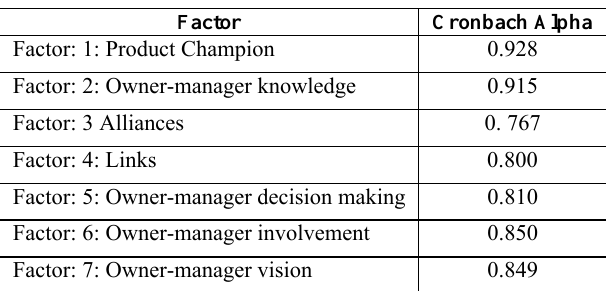
Table 2: Cronbach alpha coefficients